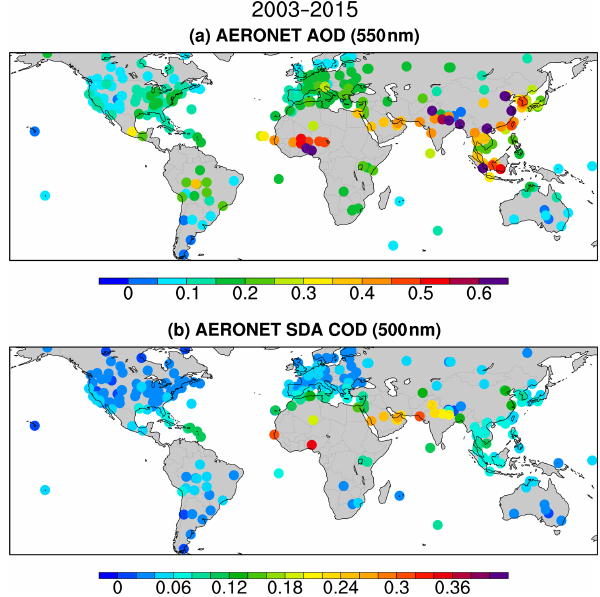
Figure 4. Climatology of annual mean AERONET (a) AOD (550nm) and (b) SDA COD (500nm) averaged over